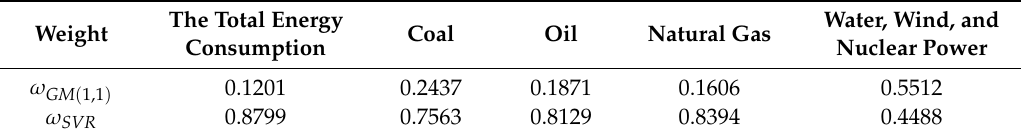
Table 4. Weight distribution of GM (1,1)-SVR.